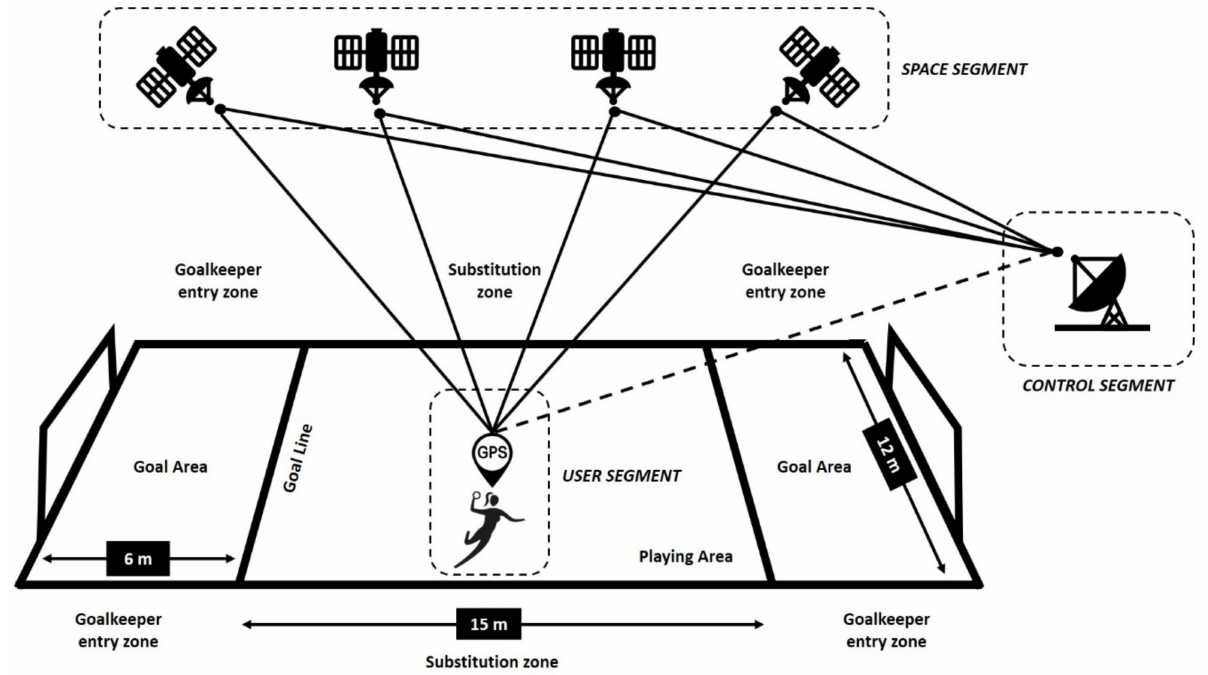
Figure 1. Application of the GPS system in beach